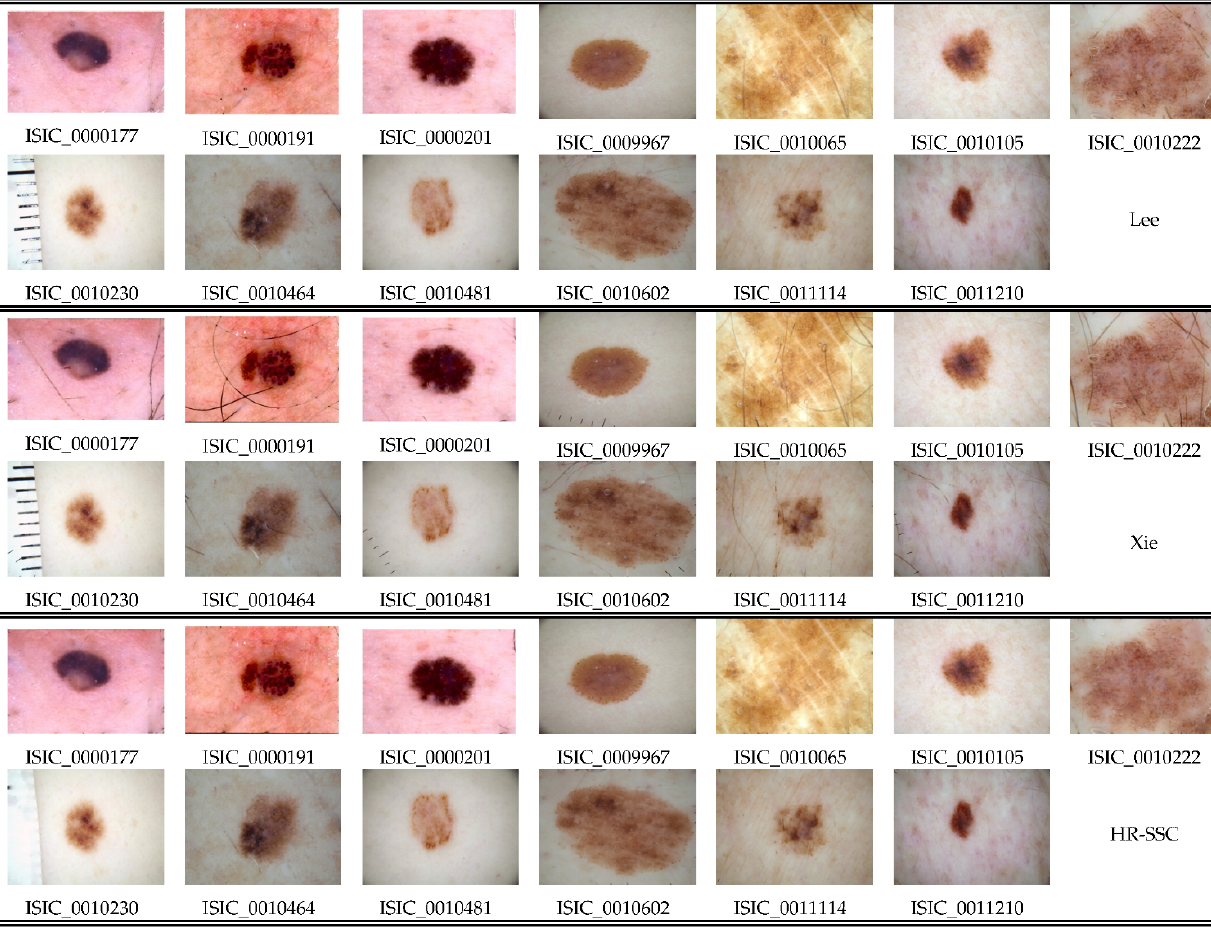
Figure 14. Results of methods Lee, Xie, and HR-SSC on sH-data .